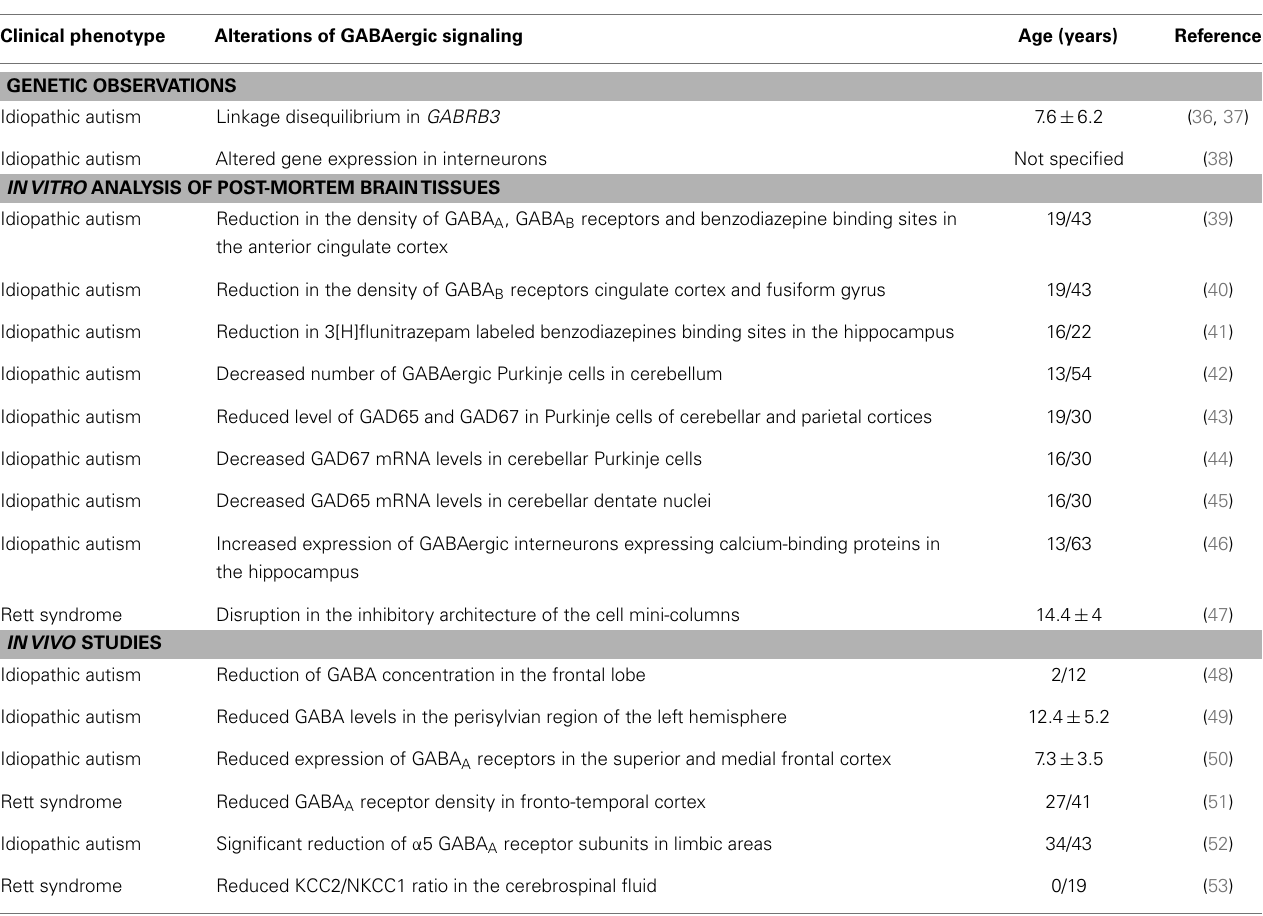
Table 1 |Alterations of GABAergic signaling in patients with idiopathic forms of autism and Rett syndrome